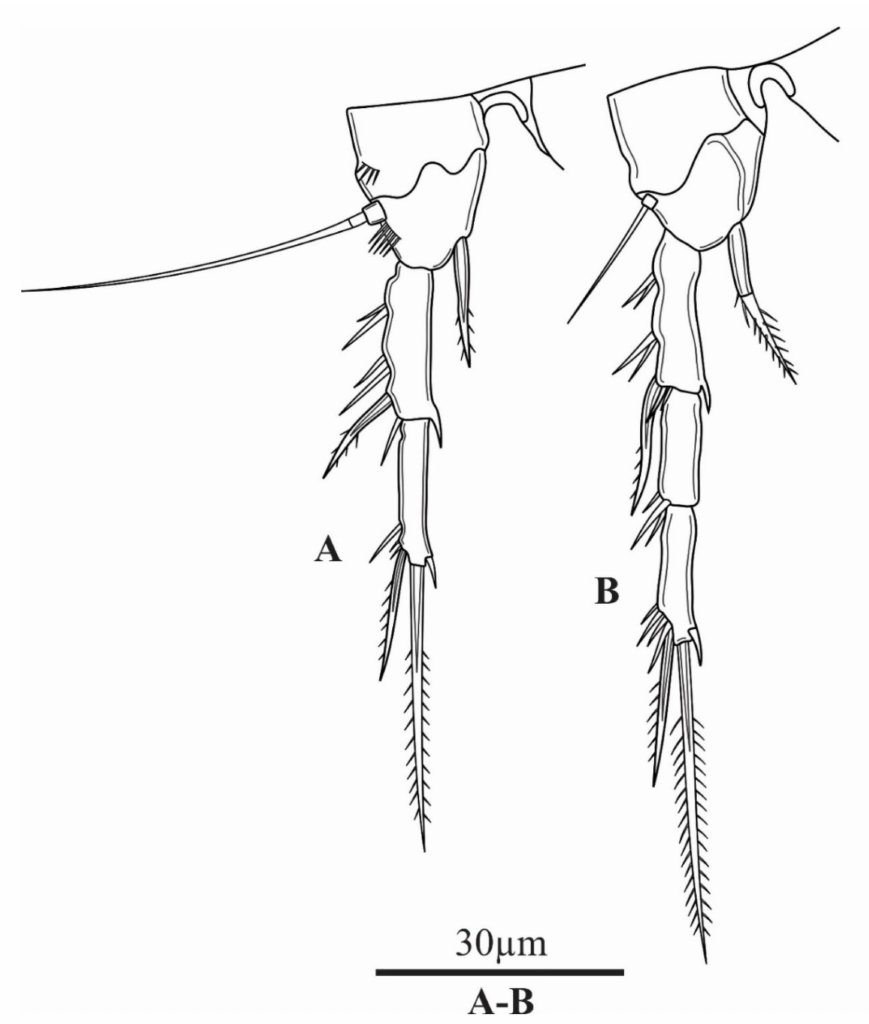
Figure 13. Parastenocaris vugiaensis sp. nov. female. ( A ), P3; ( B ), P4. P1 (Figure 12A) coxa with one anterior row of spinules. Basis with row of